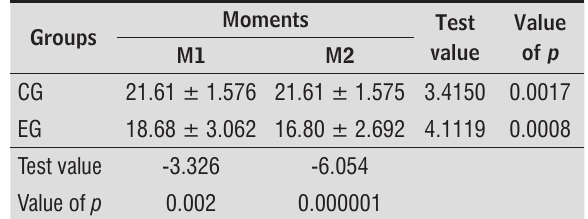
Table 3 - Mean and standard deviation of the TC10 in the two evaluation moments (M1 and M2) regarding the groups (CG and EG) and results of statistical tests. Bauru (SP-Brazil),